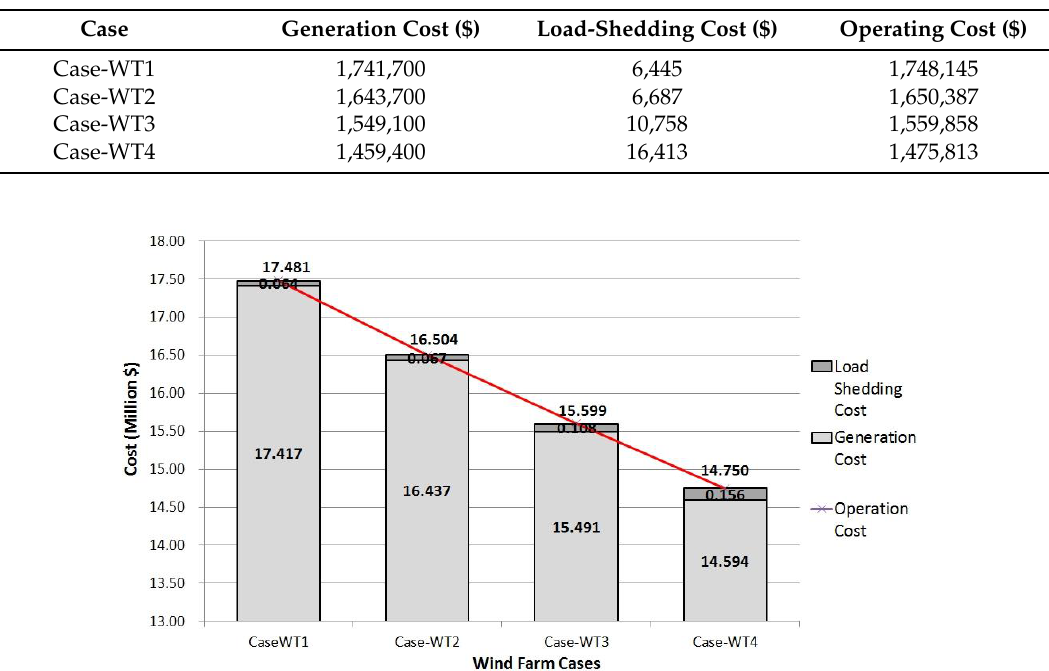
Figure 8. Calculated costs for scenarios Case-WT1, Case-WT2, Case-WT3, and Case-WT4.